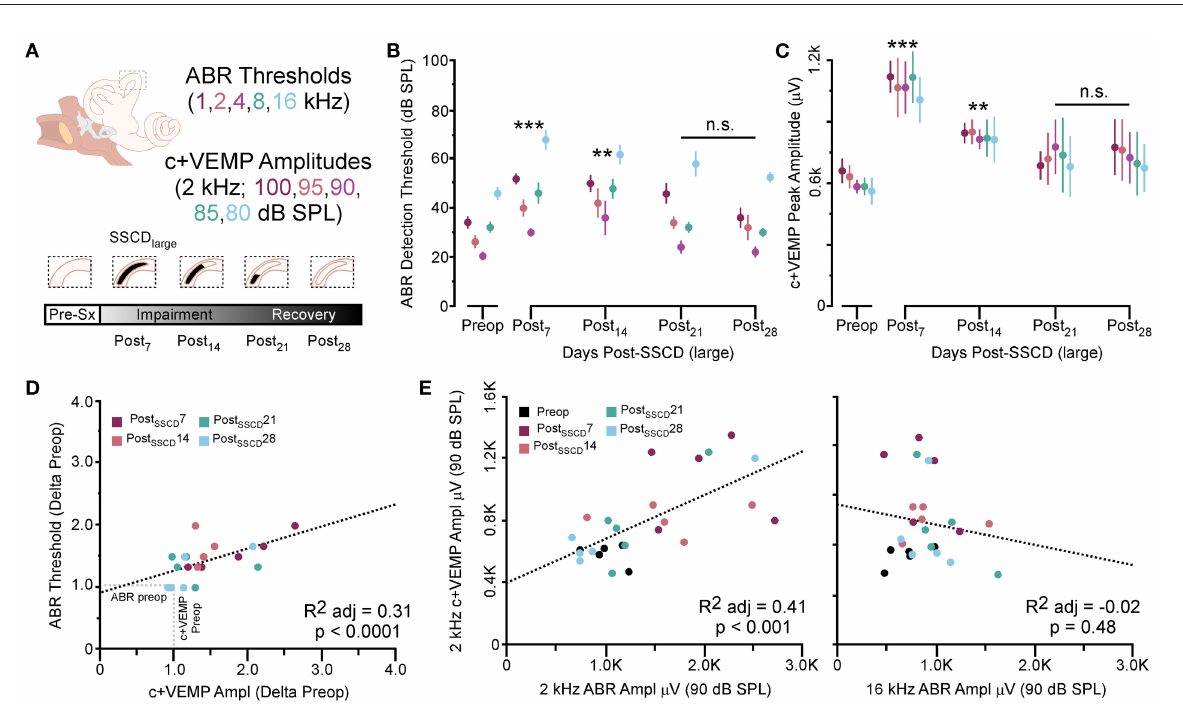
FIGURE3 The correlated group changes to sound-induced ABR thresholds and c + VEMP amplitudes after large SSCD. (A) Diagram showing the theoretical recovery of ABR thresholds and c + VEMP amplitudes over days (post-SSCD 7, 14, 21, and 28). (B) Line chart shows the group means for ABR thresholds over postoperative days in animals that received the large SSCD. (C) Line chart shows the group means for c + VEMP amplitudes over post-SSCD days in animals that received the large SSCD. (D) Scatterplot showing a significant negative correlation between auditory thresholds and c + VEMP amplitudes throughout impairment and recovery from large SSCD. (E) Scatterplot showing a significant positive correlation between c + VEMP amplitudes and ABR amplitudes at 2kHz (90 dB SPL) and a non-significant correlation between c + VEMP amplitudes and ABR amplitudes at 16kHz (90 dB SPL) for large SSCD. ** p ≤ 0.001, *** p ≤ 0.0001. ns, not